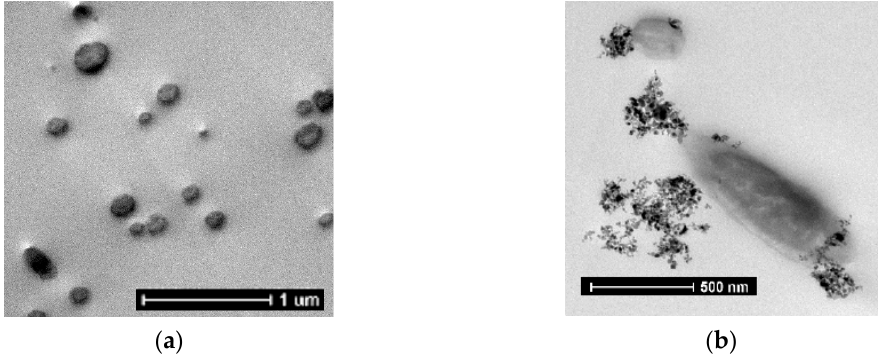
Figure 4. Transmission electron microscope (TEM) images at different magnifications ( a , b ) of PAN_TiO 2 membrane. Nanomaterials 2020 , 10 , x FOR PEER REVIEW